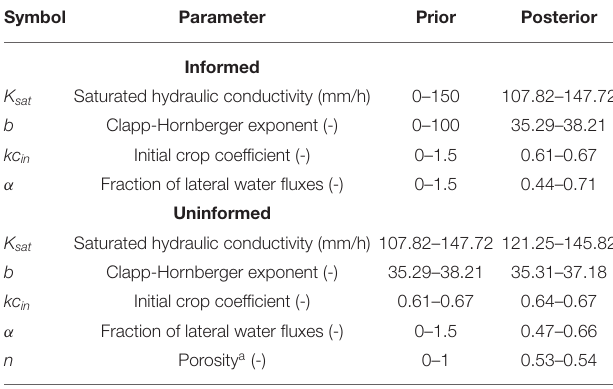
TABLE 3 | List of calibrated parameters used for modeling soil moisture dynamics, including their prior and posterior uncertainty intervals (minimum–maximum values) derived with